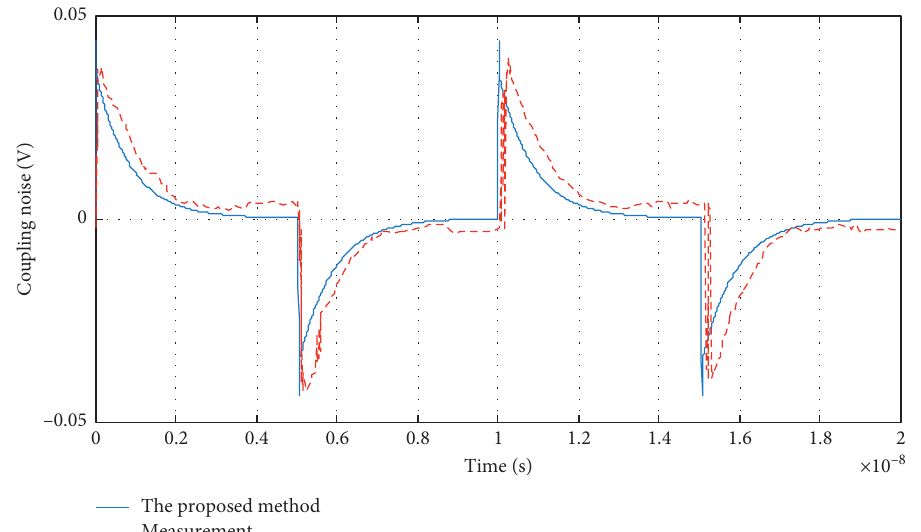
Figure 16: The proposed method and measured coupling noise of TSV-contact in the time domain (the input clock frequency at port 1 is 100MHz).